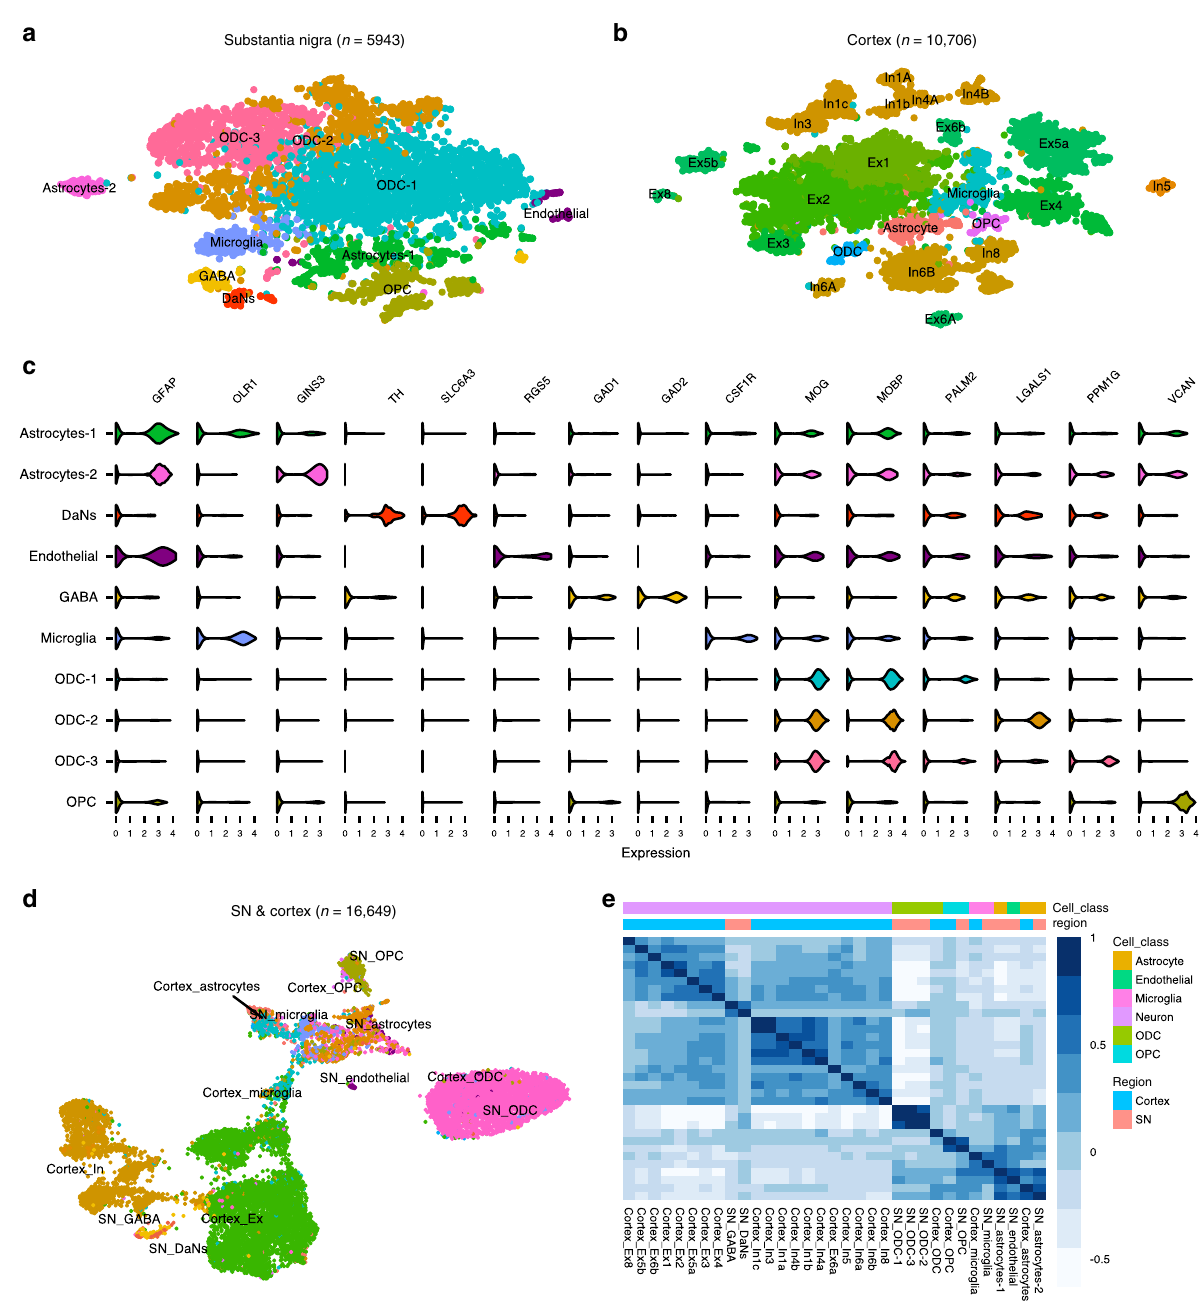
Fig. 1 Single-nuclei transcriptomic cell atlas of the adult human cortex and substantia nigra (SN). T-distributed stochastic neighbour embedding (t-SNE) plot of gene expression relationships amongst the single-nuclei cells from fi ve individuals in the ( a ) substantia nigra (SN) ( n = 5943) and ( b ) cortex ( n = 10,706). c Violin plots of expression values (log10 TPM values) of enriched cell-type-speci fi c markers for the cell types in the SN (Supplementary Data 3). d Uniform manifold approximation and projection (UMAP) plot of both the cortex and substantia nigra cell types ( n = 16,649 cells) showing distinct clustering by cell type. e Correlation heatmaps showing hierarchical clustering of Pearson correlation scores calculated between averaged cell-type subclusters in both regions. The transcriptional correlation is largely explained by cell type and not by the region of origin. DaNs dopaminergic neurons, Ex excitatory neurons, GABA GABAergic neurons, In inhibitory neurons, ODC oligodendrocytes, OPC oligo-precursor study variation to be performed for cell types across these two homogenous cell atlas (Supplementary Fig. 6) (SN R = 0.83 ( p < brain regions (Supplementary Note 3). We examined the effects 10 − 16 ) and cortex R = 0.72 ( p < 10 − 16 )), showing that the cellular proportions do not obscure the cell-type associations within the of the differing neuron/glial cell proportions between the SN and same tissue. Nevertheless, only the cross-tissue cell-type condi- cortex upon genetic risk/cell associations by creating arti fi cially tional analysis conducted within the homogeneous cell atlas matched SN/cortex cellular atlases possessing the same propor- revealed that the PD genetic risk associated with the SN DaNs and tion of glial cells by randomly sampling the original cellular cortex Ex gene expression pro fi les was indistinguishable (Supple- populations ( “ Methods ” ). We observed a large agreement in the mentary Table 8, p = 0.15 (homogenous cell atlas)/ p = 0.049 genetic risk/cell associations between the original and the